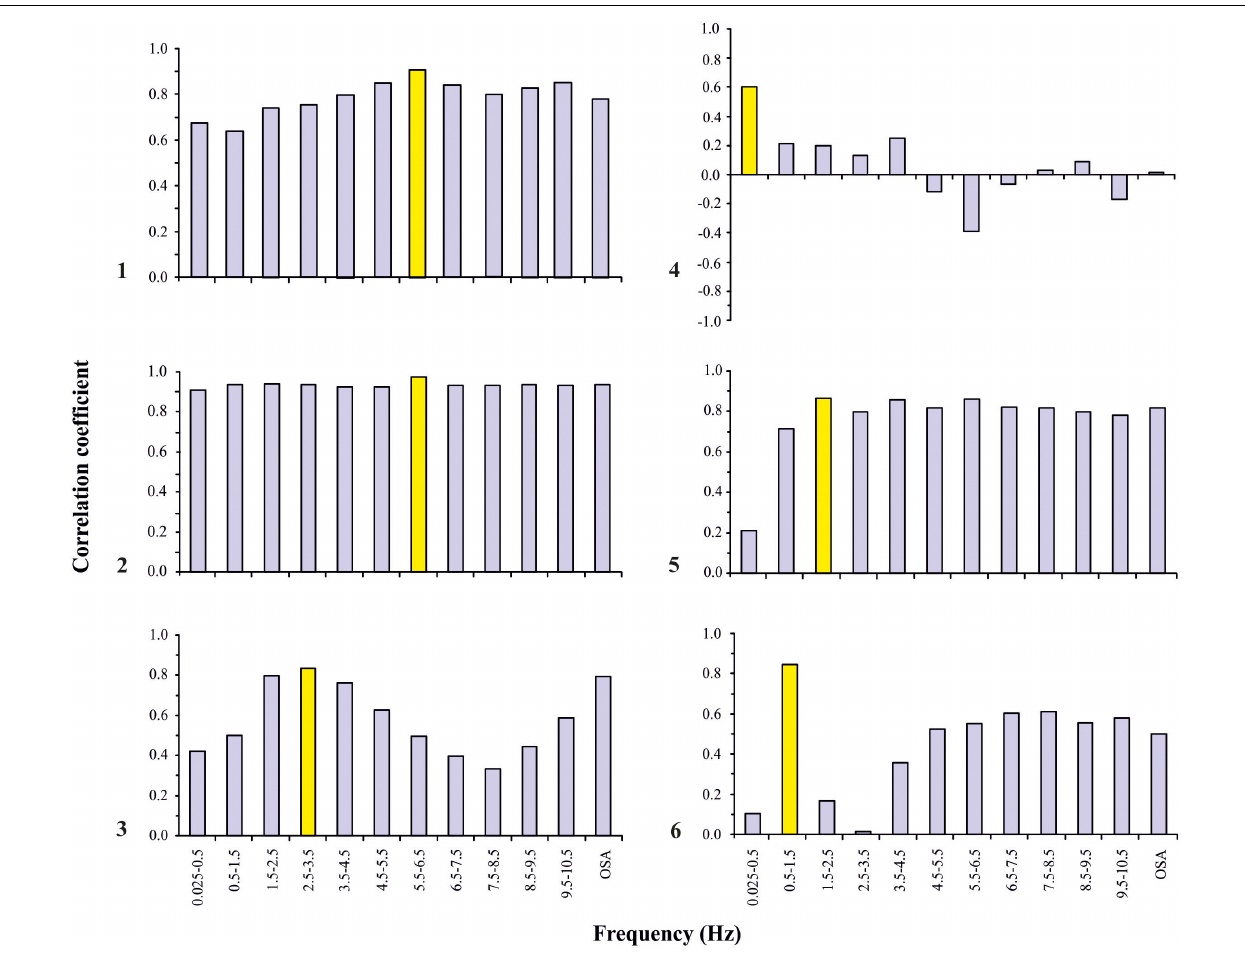
FIGURE 4 | Correlation coefficient of SO 2 flux vs. volcanic tremor in the six intraday case studies investigated at frequency bands between 0.025 and 10.5 Hz and OSA. Overall, the two parameters show reliable correlation between 0.6 and 0.9 Hz (Leonardi et al., 2000b). In each of the six histograms, the yellow bin represents the maximum correlation between the SO 2 flux and volcanic tremor. In detail, case studies 1, 2, and 5 (except for the frequency below 0.5 Hz) show good correlation at almost all frequencies. Case studies 3 and 6 display bimodal distribution of the correlation coefficients with dominant frequencies centered at 3 and 1 Hz in case study 3 and 6, respectively. Case study 4 is characterized by both positive and negative correlation coefficient values. The positive maximum value corresponds to below 0.5 Hz. The negative bars indicate the frequencies at which SO 2 flux and volcanic tremor